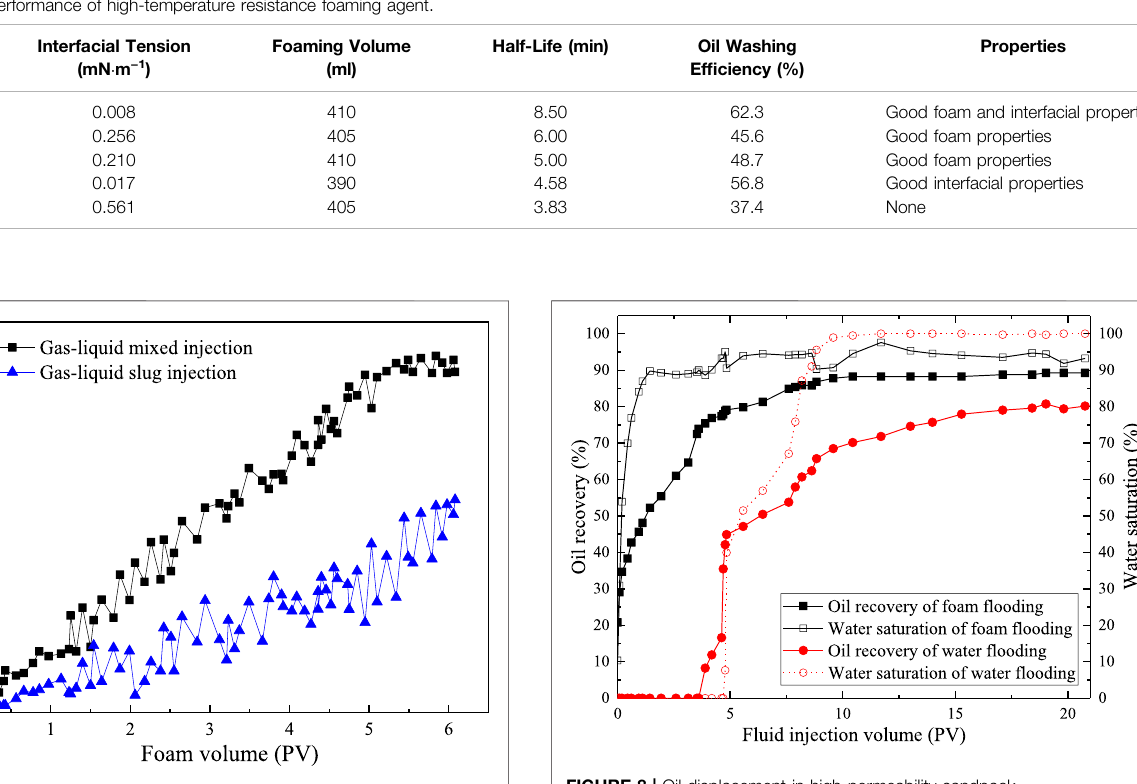
FIGURE 6 | Variation of RF with foam injection amount under different injection methods (Temperature was 200 ° C, injection rate was 3.5 ml min − 1 , gas liquid ratio was